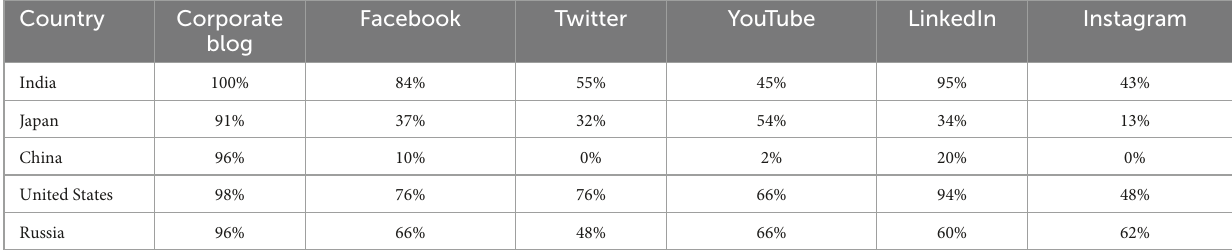
TABLE 2 Social media platforms adopted by each country.